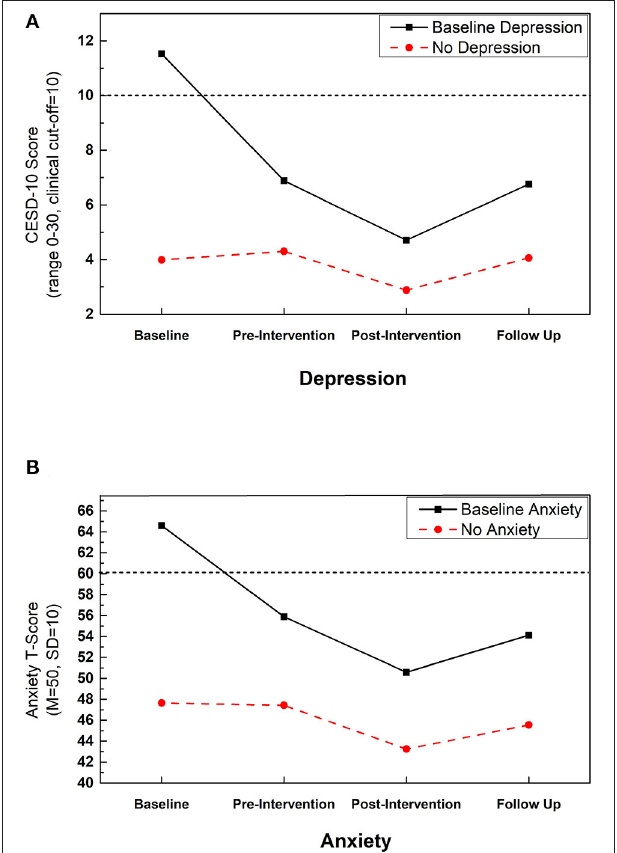
FIGURE 3 | Improvements in depression and anxiety with Samyama: change in (A) depression and (B) anxiety across assessment timepoints separated by those with and without scores above the clinical cutoff at baseline for each measure. Dotted line indicates clinical cutoff for relevant measure. Depression was assessed with the 10-item Center for Epidemiological Studies Depression scale (CESD-10). Anxiety was assessed with the PROMIS Emotional Distress Anxiety—Short Form